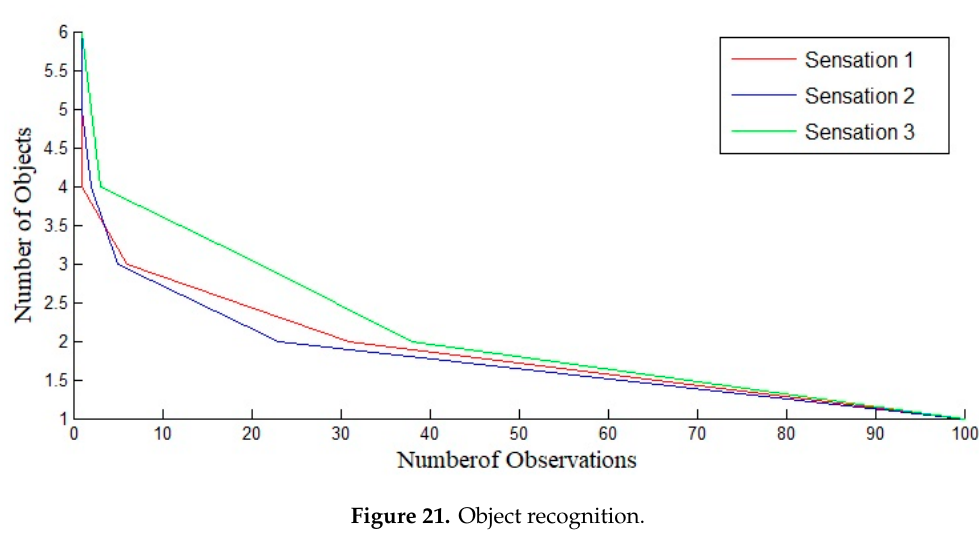
Figure 21. Object recognition.